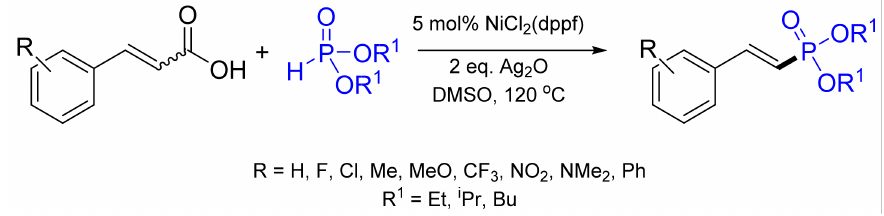
Figure 35. Decarboxylative cross-coupling of alkenyl acids with P(O)H